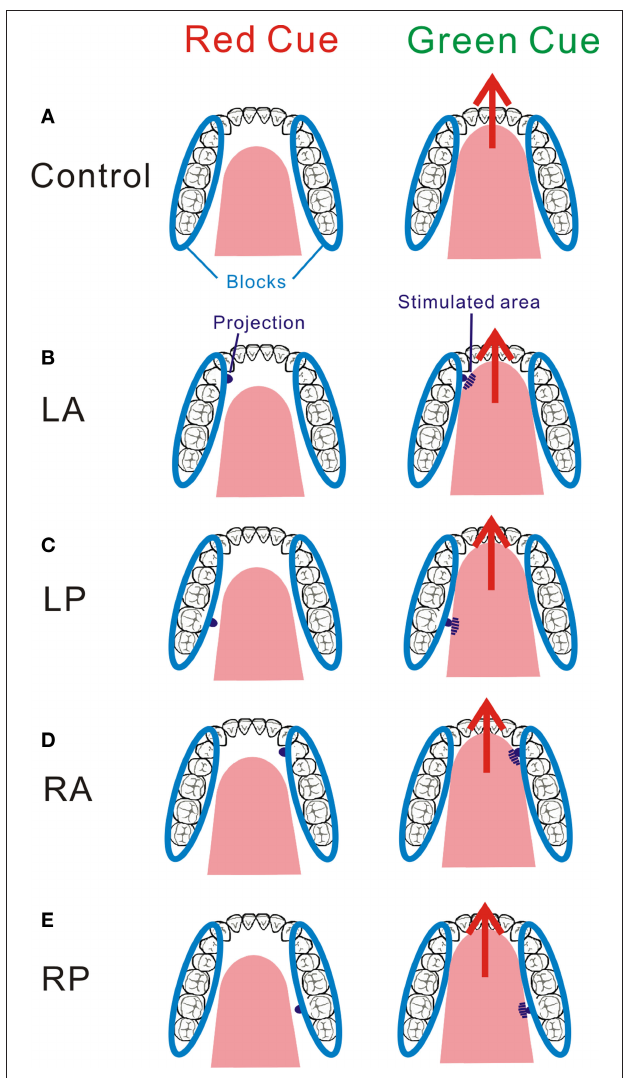
FIGuRE 7 | Group activation map showing activated brain regions in four conditions. The figures around SI areas were enlarged for all conditions. Using the Statistical Parametric Mapping 2 (SPM2, Wellcome Department of Cognitive Neurology, London, UK) template, areas showing an increase in BOLD-signal are superimposed on a 3D-rendered standard brain. Although our statistical threshold was P < 0.001 (uncorrected), the threshold was lowered to P < 0.05 (uncorrected) for this figure for display purposes. Adopted from Sakamoto et al. (2010).